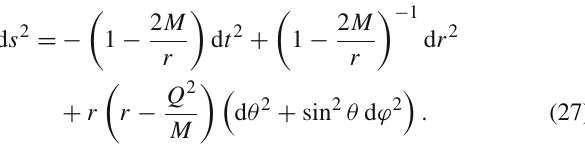
Fig. 5 The evolution of the areal radius (blue dashed curve) and the mass (red solid curve) of a charged dilatonic GHS black hole as func- tions of time, assuming that there is no charge loss. Here we choose initial mass to be M ( 0 ) = 10 and Q = 1. The mass thus asymptotes to √ its lower bound M = Q / 2 ≈ 0 . 7071. The evolution takes an infinite amount of